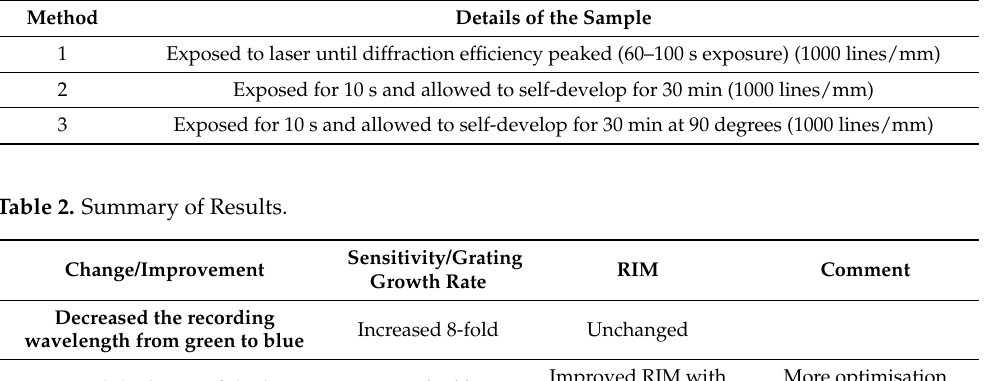
Table 1. Description of the recording conditions for samples in Figure 10.